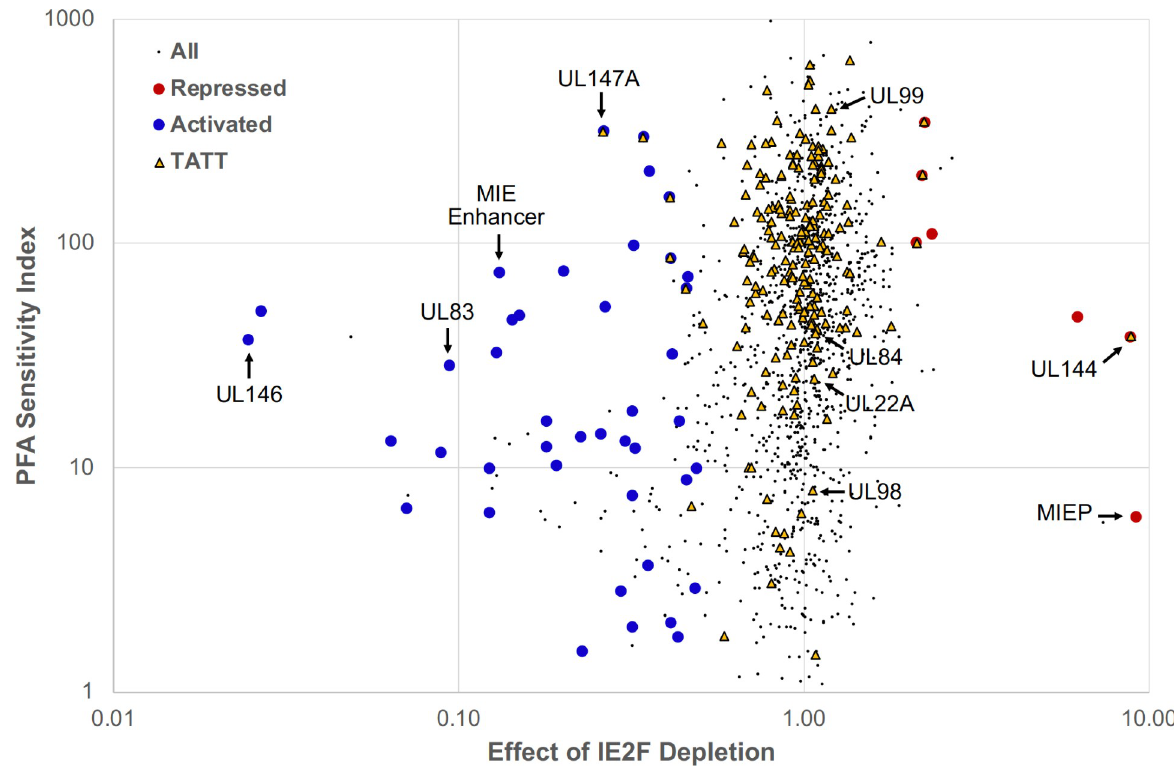
Fig 5. PSI score versus effect of IE2F depletion on TSR strength. Each TSR is indicated by a small black dot. Repressed and activated TSRs increase and decrease in strength, respectively, when IE2F is depleted. Repressed TSRs containing a dTag / CTRL ratio greater than 2 are red. Activated TSRs with ratios less than 0.5 are blue. TSRs with an upstream TATT sequence are shown as yellow triangles. TSRs immediately downstream (within ~200 bp) from major TSRs that are due to 5´ ends generated by hydrolysis and not actual transcription initiation were removed from the repressed and activated lists. Such TSRs still appear in the plot as black dots but are not identified as activated or repressed. Arrows point to TSRs for the indicated viral promoters.